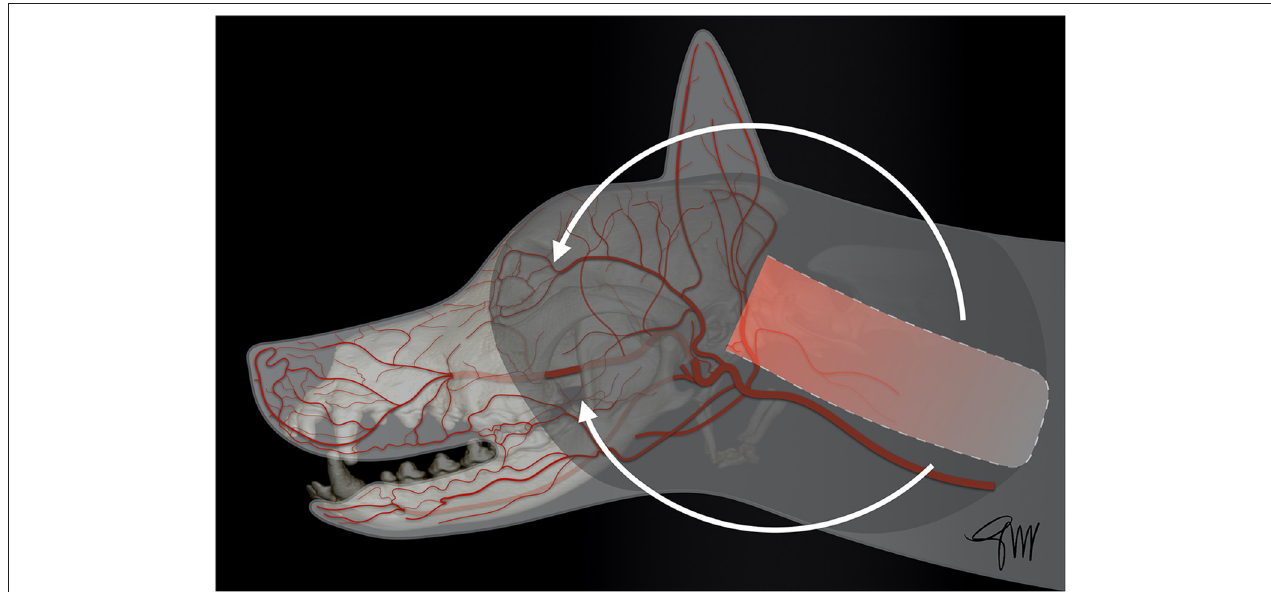
FIGURE 9 | Drawing depicting the surgical limits and extent of rotation of a caudal auricular myocutaneous axial-pattern flap.